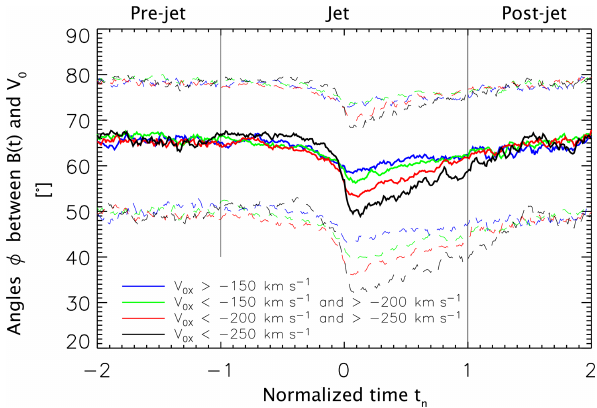
Figure 4. Superposed epoch analyses of the angle φ B , V only jets occurring under IMF cone angles of < 30 ◦ (blue; 2811 contributing jets), between 30 and 50 ◦ (green; 4119 contributing jets), and above 50 ◦ (red; 2827 contributing jets), respectively. As in Fig. 3, solid lines show median values, and dashed lines show upper and lower quartiles.